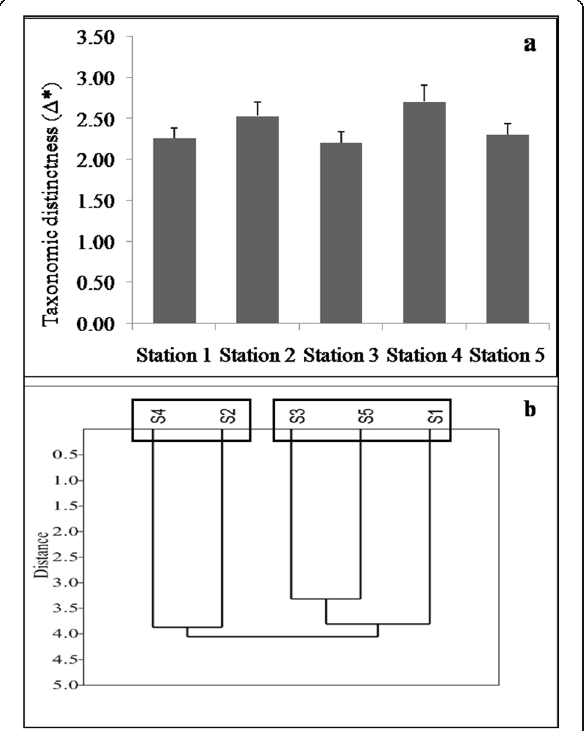
Fig. 4 Taxonomic distinctness ( a ), and cluster analyses based on density of wetland vegetation ( b ). Station 1 (S1), inlet point 1; Station 2 (S2), middle point 1; Station 3 (S3), inlet point 2; Station 4 (S4), middle point 2; and Station 5 (S5), outlet